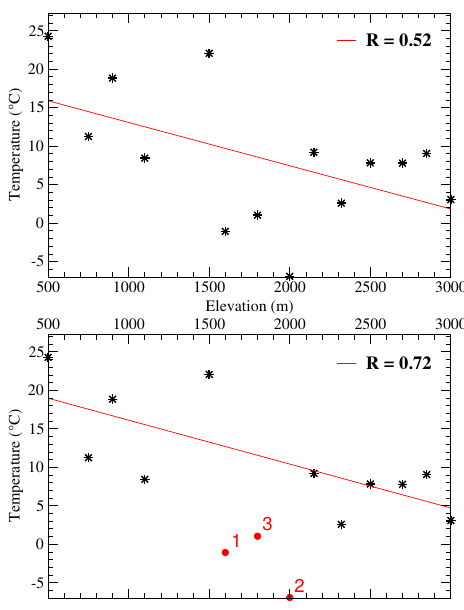
Figure 8. Removing outliers for computing lapse